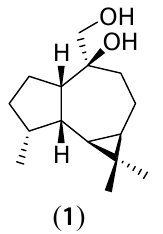
Figure 1: (+)-10 β ,14-Dihydroxy- allo -aromadendrane ( 1 )